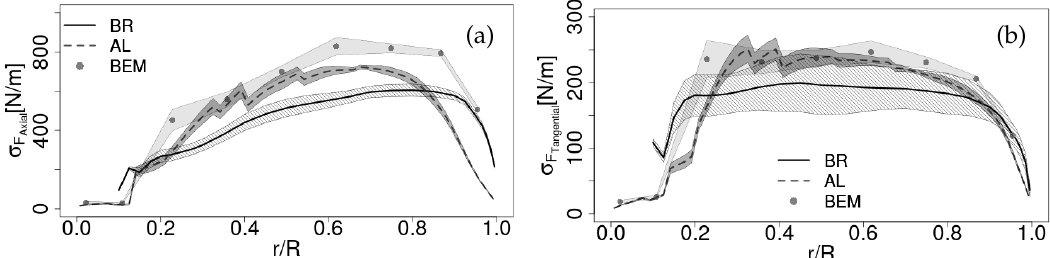
Figure 6. Radial distribution of standard deviation of ( a ) axial and ( b ) tangential forces per unit span. The shaded areas correspond to